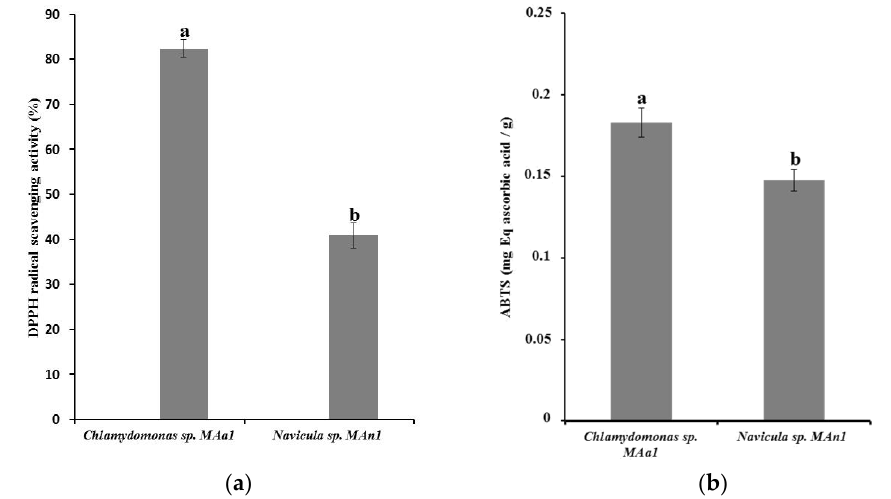
Figure 1. Non enzymatic antioxidant activities of Chlamydomonas sp. MA a1 and Navicula sp. MA n1 methanol extracts. ( a ) DPPH scavenging activities; ( b ) ABTS scavenging activities. Data show means ± SD ( n = 3). Statistical significance was determined by a Student’s t test; significant difference ( p < 0.05) is indicated by different lowercase letters.